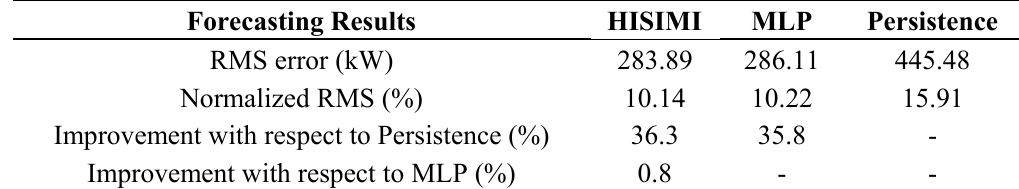
Table 4. Summary of forecasting